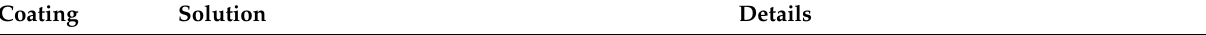
Table 2. Treatment of CF